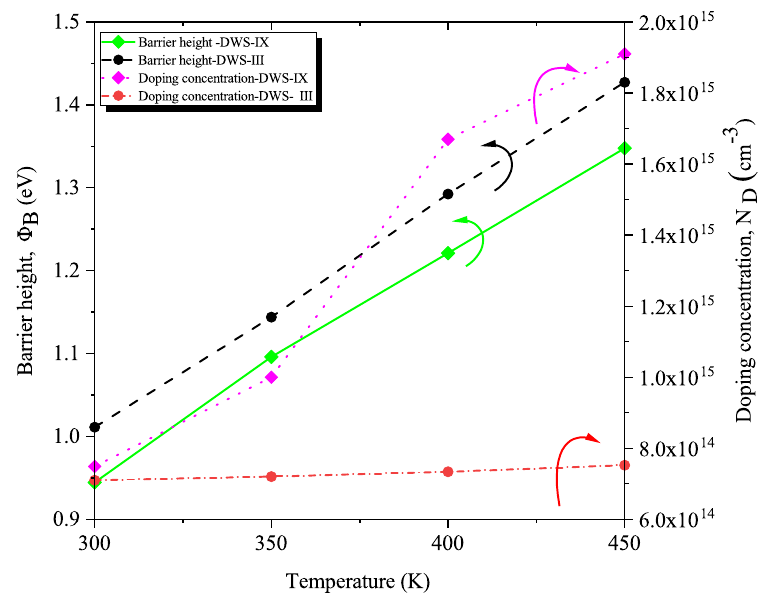
Figure 7. The barrier height and doping concentration plot as a function of various temperatures deduce from C-V-T measurement for diffusion welded p -type 4H-SiC-SBD (DWS# III and DWS#